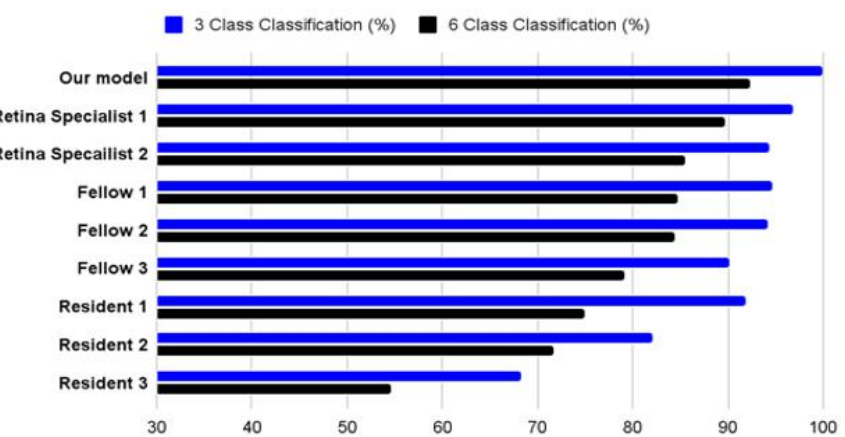
Figure 4. Comparison of classification performance between our model and eight ophthalmologists using an external test dataset. Our model ’ s classification accuracies were 100 and 92.3% in 3-class and 6-class classifications, respectively. In addition, our model recorded the highest performance compared with the eight ophthalmologists in both tests.